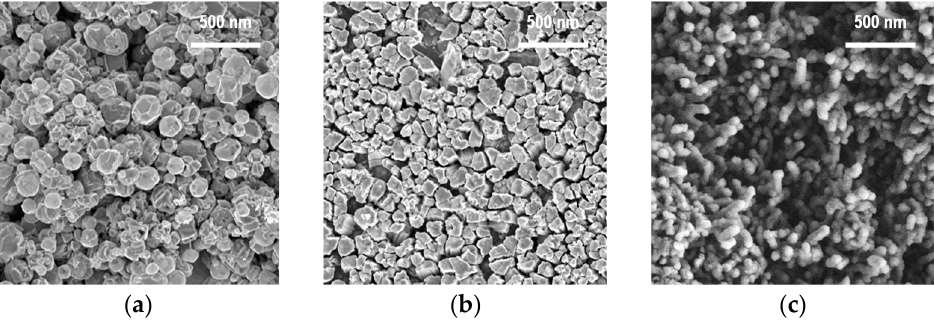
Figure 3. The SEM images of the ZnO nanopowders obtained by the PECVD method at the various zinc source temperatures: ( a ) 370 °C, ( b ) 420 °C, ( c ) 470 °C.